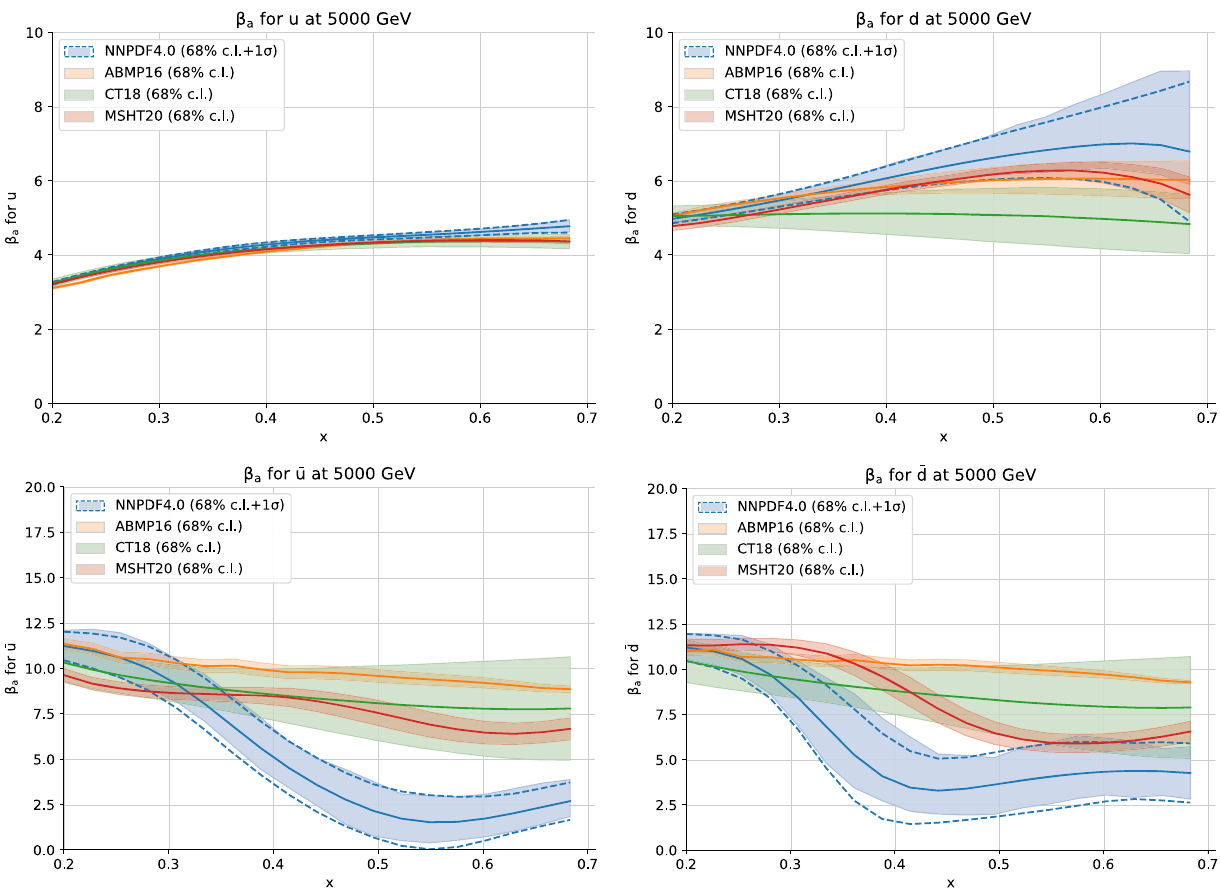
Fig. 10 The large- x asymptotic exponents β a , q ( x , m (cid:2) ¯ (cid:2) ) , defined in Eq. (3.6), for ABMP16, CT18, MSHT20, and NNPDF4.0 evaluated at m (cid:2) ¯ (cid:2) = 5 TeV for the up and down quark and antiquark PDFs